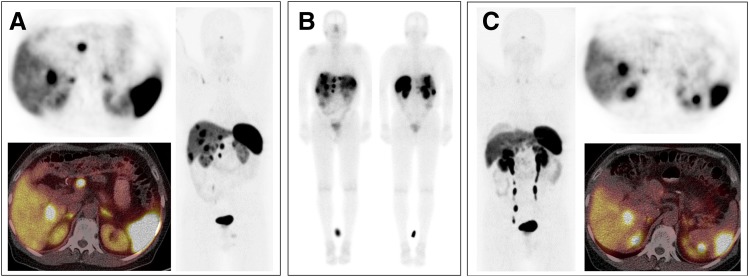
Representative examples of clinical PRRT images. PRRT in a 73-year-old patient with metastasized neuroendocrine cancer (G1). Pretherapeutic 68Ga-DOTANOC PET/computed tomography images show extensive metastases in the liver and additional abdominal lymph node metastases (A). Post-therapeutic whole-body scintigraphy after application of 177Lu-DOTATATE confirms uptake in metastatic lesions (B). After four cycles of 177Lu-DOTATATE, 68Ga-DOTANOC PET/computed tomography demonstrates considerable response of liver and abdominal lymph node metastases (C). Images courtesy of M. Eiber, Department of Nuclear Medicine, Technical University Munich, Germany.